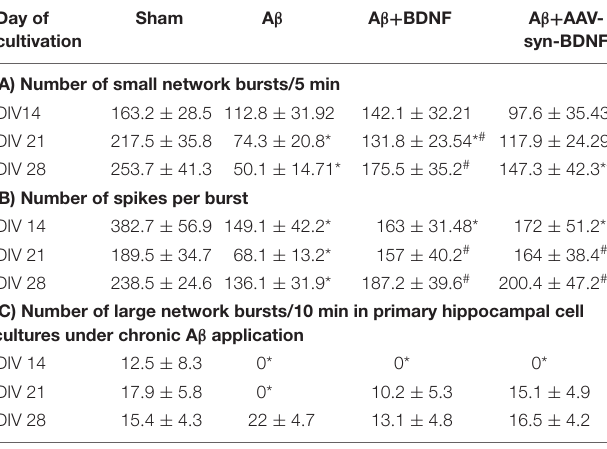
TABLE 3 | Main parameters of spontaneous bioelectrical activity in primary hippocampal cell cultures under chronic A β application. Day of